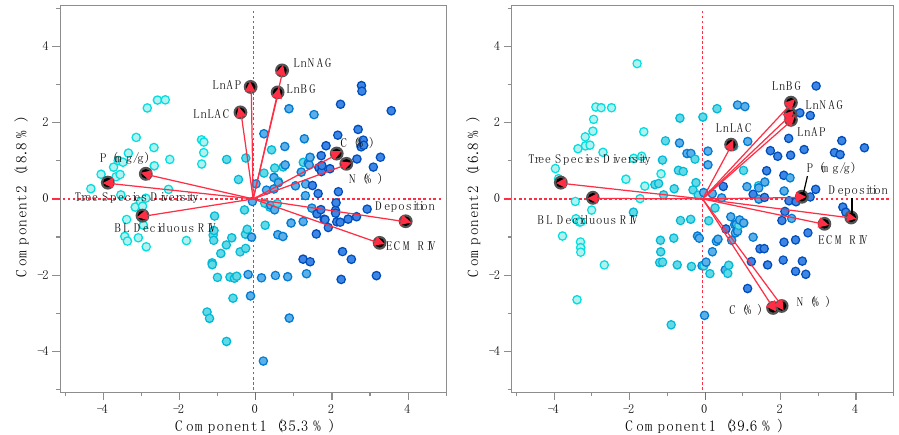
Figure 4. Principle component analysis for soil extracellular enzyme activities and soil-level and plot-level predictors of ESE activities in the organic and mineral horizons, respectively. Symbol color intensity reflects N deposition at each site (light blue, low, to dark blue, high, N deposition).